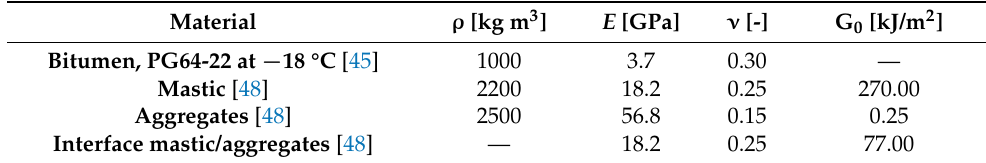
Figure 6. ( a ) PA #2/0.65% ice; ( b ) PA #2/1.3% ice; ( c ) PA #2/3.25% ice; ( d ) PA #2/6.5% ice; ( e ) PA #2/9.75% ice; ( f ) PA #2/13% ice Ice is represented by yellow particles. Table 5. Mechanical properties of bitumen, mastic and aggregates at − 10 °C used in the simula- tions.